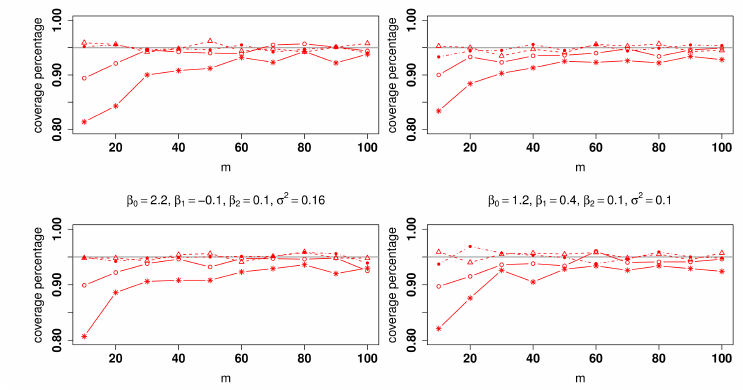
Figure 5. Our 95% coverage percentage for β 0 , β 1 , β 2 , and σ 2